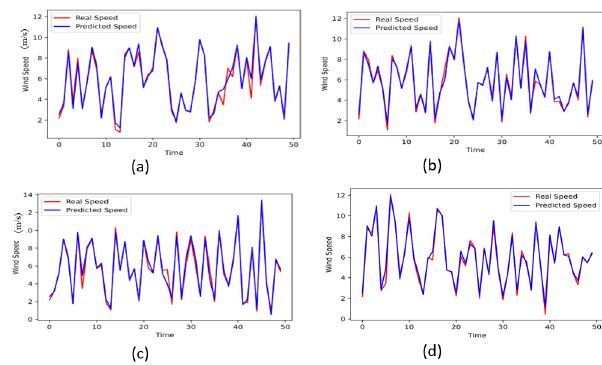
Figure 13. Wind speed prediction in Case 1. (a) 1 hour ahead (b) 2 hours ahead, (c) 5 hours ahead, (d) 7 hours